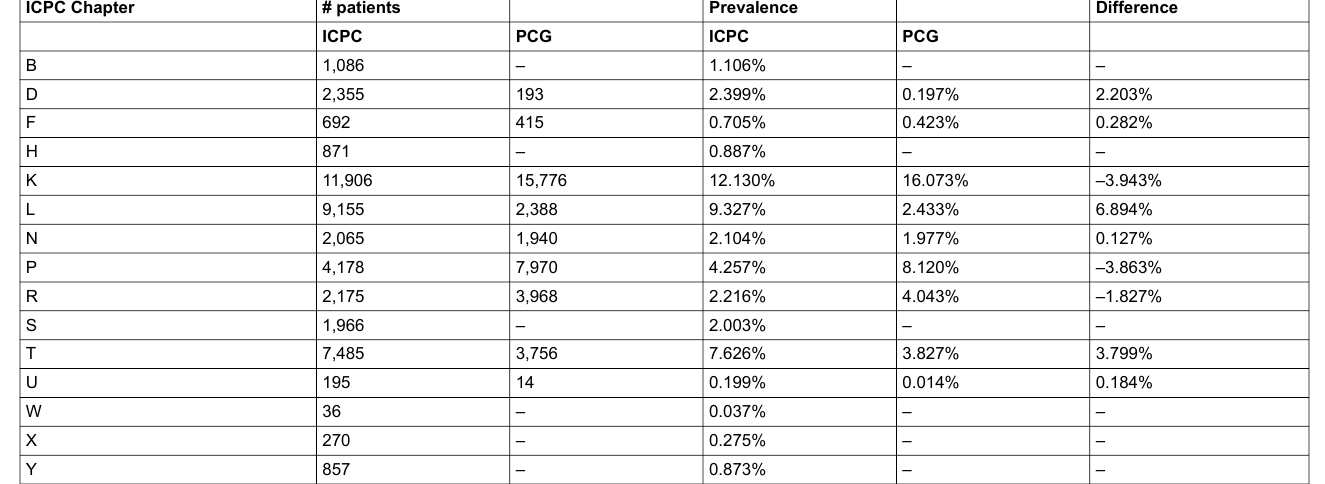
Table 2: Prevalence estimates of patients with chronic conditions using ICPC or PCG based coding procedures (total number of patients: